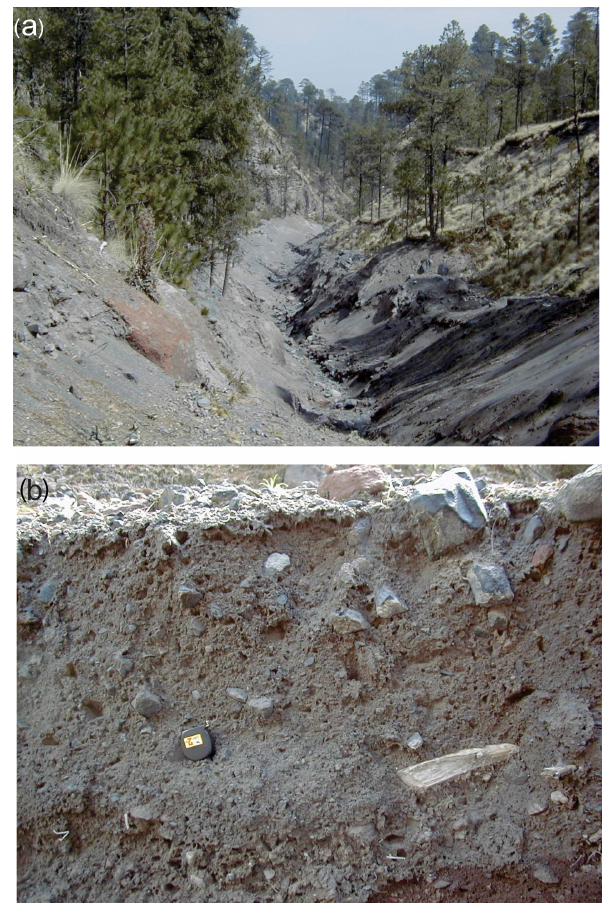
Figure 3. Photographs of the 2001 lahar deposit. (a) Proximal fa- cies of the deposit. (b) Textures of the 2001 lahar deposit where the massive structure and clasts dispersed in a sand–silty matrix are observable.